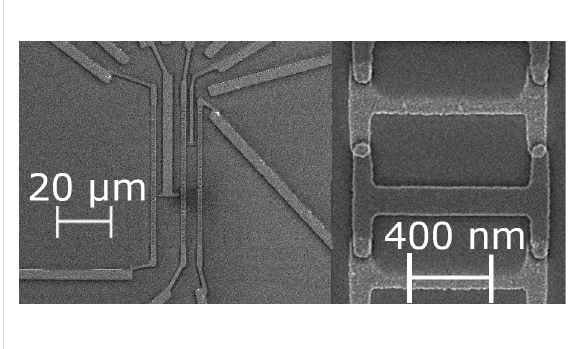
Figure 1: SEM images of the test sample fabricated from supercon- ducting thin film aluminum oxidized in situ to form tunnel barriers. Left panel: overview of the structure. Right panel: details of the JJ